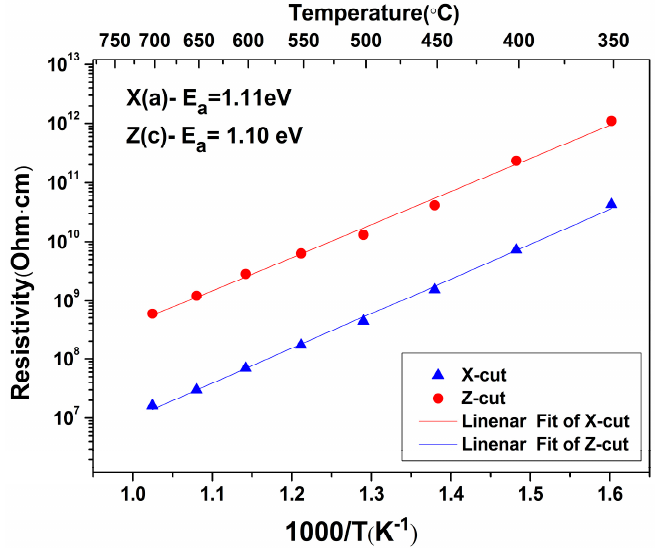
Figure 4. Temperature dependence of the resistivity of grown CYAM Figure 4 Temperature dependence of the resistivity of grown CYAM crystal.